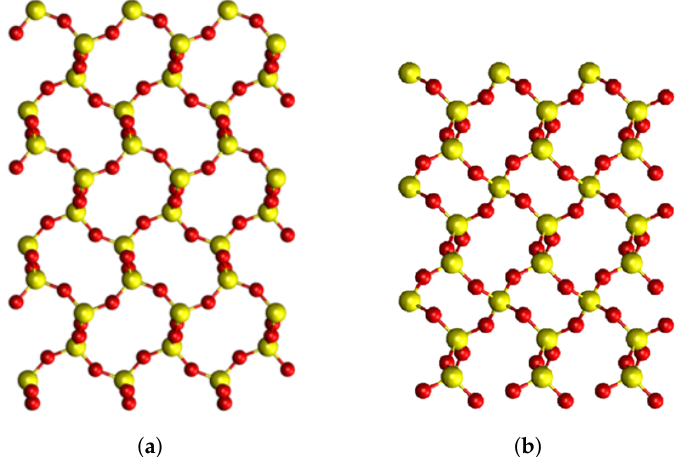
Figure 1. Pristine structures of SiO 2 in different phases, viewed along the a axis. Yellow atoms correspond to Si, red atoms correspond to oxygen atoms. ( a ) α -cristobalite structure; ( b ) α -quartz structure. Both phases are on the same scale as α -quartz has a smaller unit cell than α